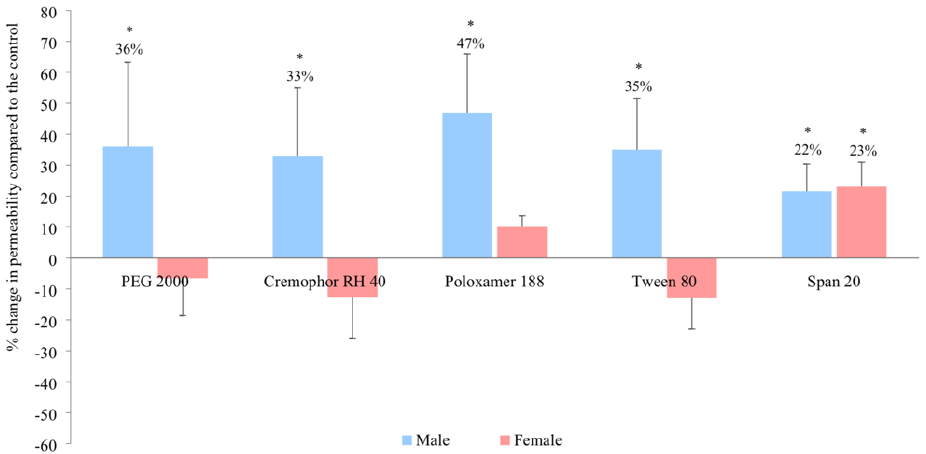
Figure 2. Percentage change in in vitro ranitidine permeability in the rat jejunum in the presence of the different excipients in males and females (mean ± SD, n = 6). * Values are statistically different when compared to the control (i.e. no excipient) and the excipient groups at p < 0.05.